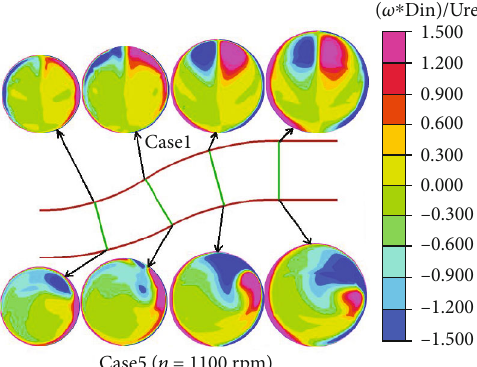
Figure 13: The vorticity distribution on cross section for the S- shaped